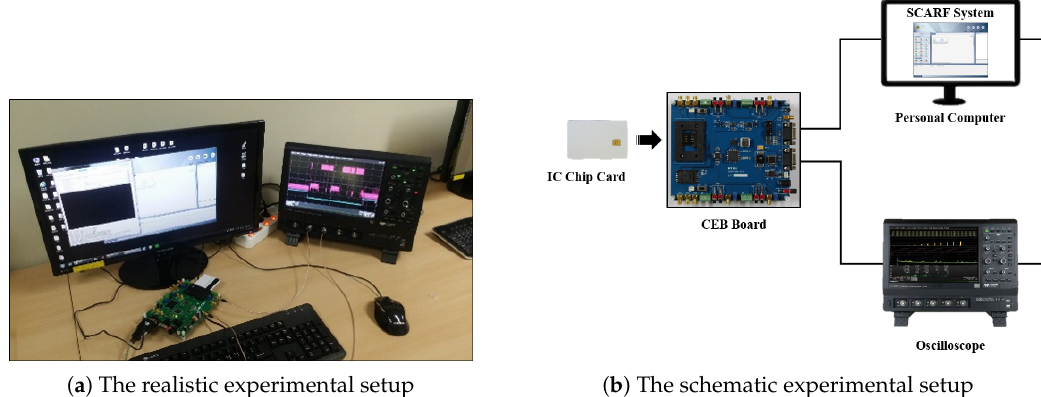
Figure 2. Experimental setup for security evaluation of financial IC card